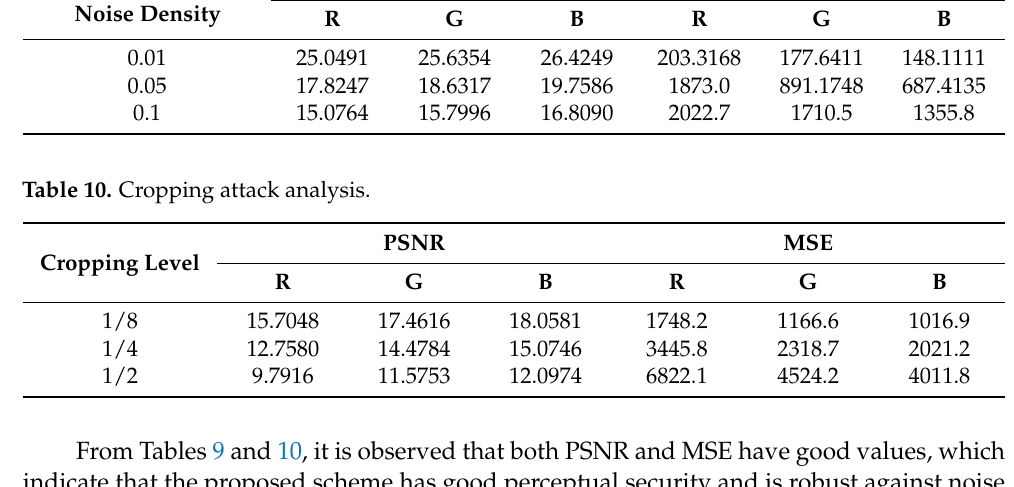
Table 10. Cropping attack analysis.